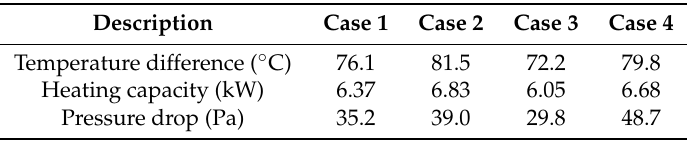
Table 6. Analysis results of high voltage PTC